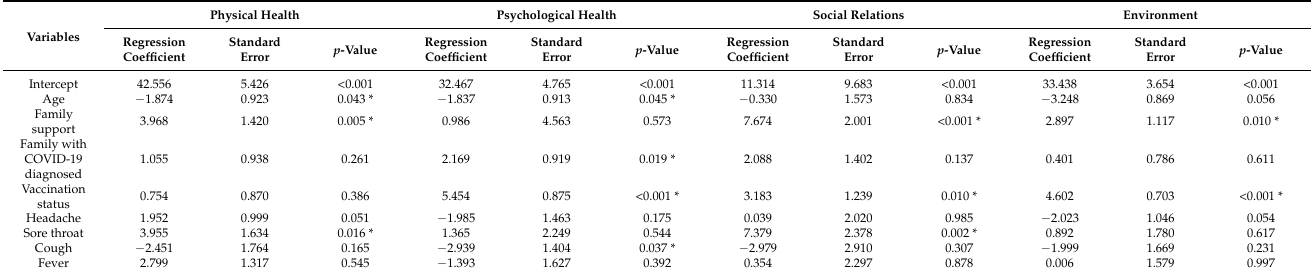
Table 8. Linear regression models for physical health, psychological health, social relations, and environment.